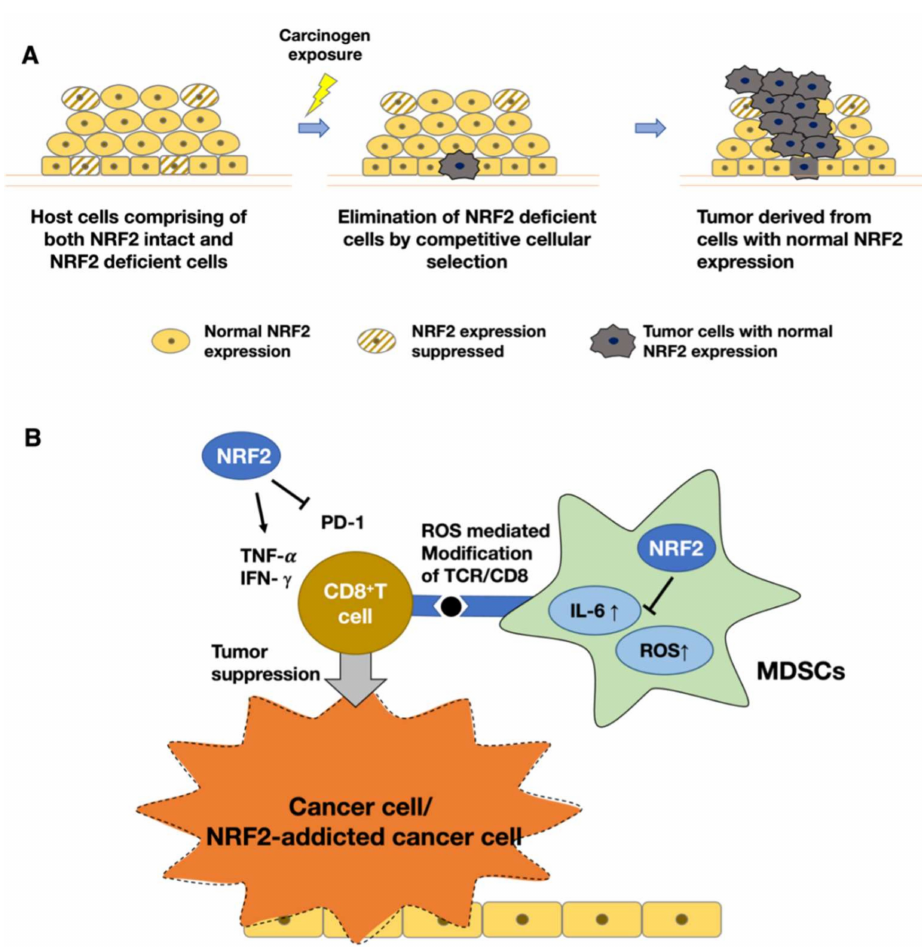
Figure 5. ( A ) NRF2-null cells are eliminated by competitive cell selection during chemical carcino- genesis. Upon exposure to chemical carcinogens, NRF2-null cells are eliminated by competitive cell selection, and then, NRF2-intact neighboring cells undergo carcinogenesis. ( B ) NRF2 activation in immune cells leads to tumor suppression. NRF2 activation elicits a cancer suppressive effect by decreasing the reactive oxygen species (ROS) and IL-6 levels in myeloid-derived suppressor cells (MDSCs). An increase in ROS levels modifies the interaction between a major histocompatibility complex (MHC) class I molecule and the T cell receptor (TCR)–CD8 complex. This results in a severe decrease in CD8 + T cell levels. NRF2 activation in the microenvironment restores the activity of CD8 + T cells, which also facilitates the suppression of NRF2-activated cancer. NRF2 upregulates the expression of tumor-suppressing genes such as TNF- α and IFN- γ , but it downregulates the